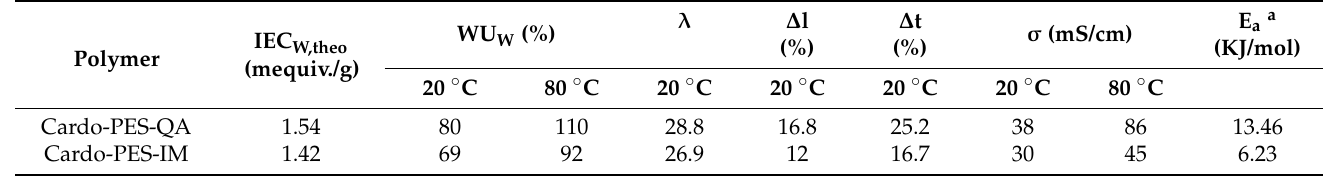
Table 3. Anion exchange membrane properties of cardo-PES-QA and cardo-PES-IM copolymers. IEC W,theo Polymer (mequiv./g)